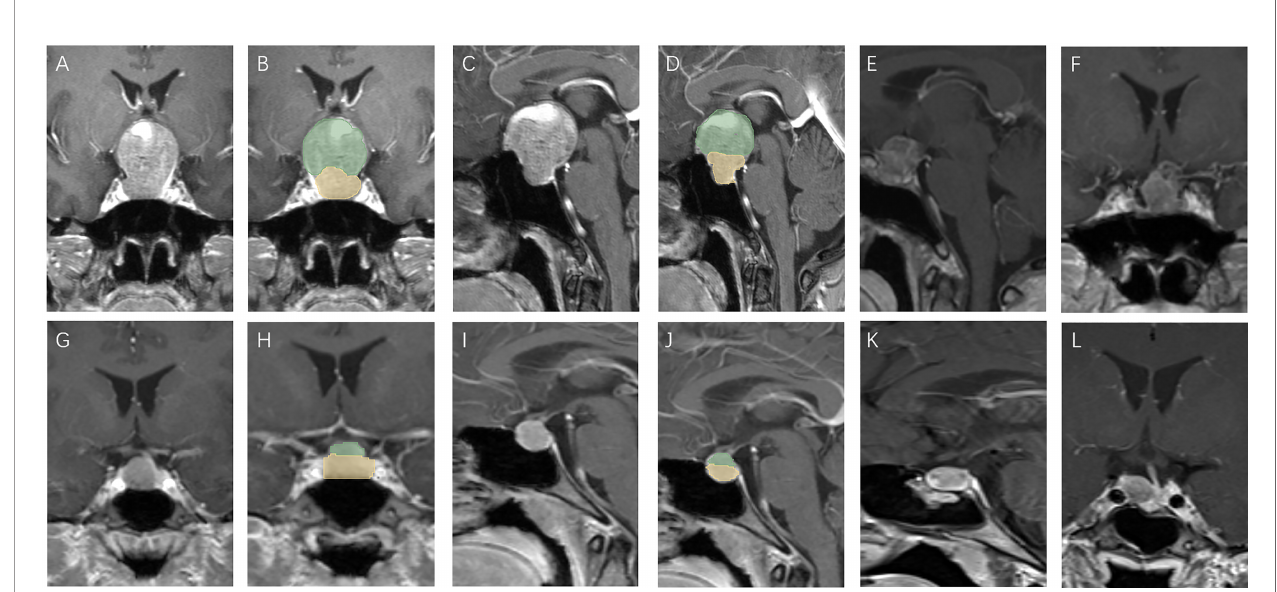
FIGURE 3 | Patients with high V-D value: A 51 year old female, TV: 13699.48 mm 3 , V2: 1620.19 mm 3 , V1:12079.29 mm 3 , V-D: 8.64 (A – D) , relapse 13 months after surgery (E, F) ; a 30 year old female, TV: 470.46 mm 3 , V2: 186.48 mm 3 , V1:283.98 mm 3 , V-D: 2.56 (G – J) , relapse 94 months after surgery (K, L)